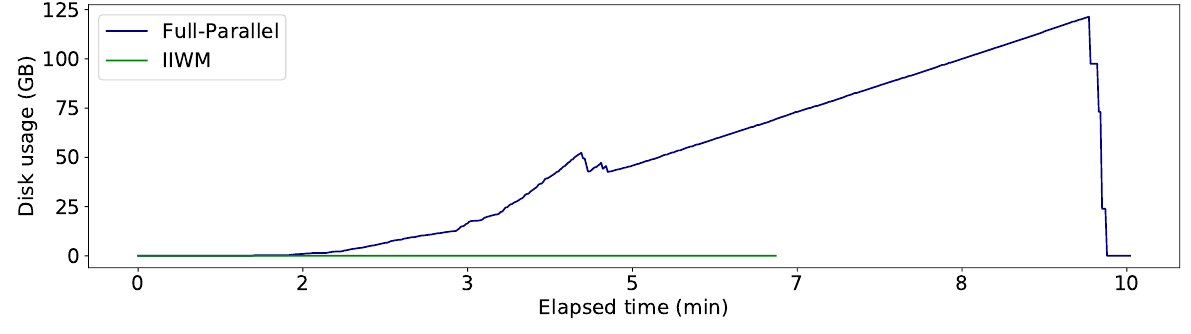
Figure 10. Disk usage over time for full-parallel and the